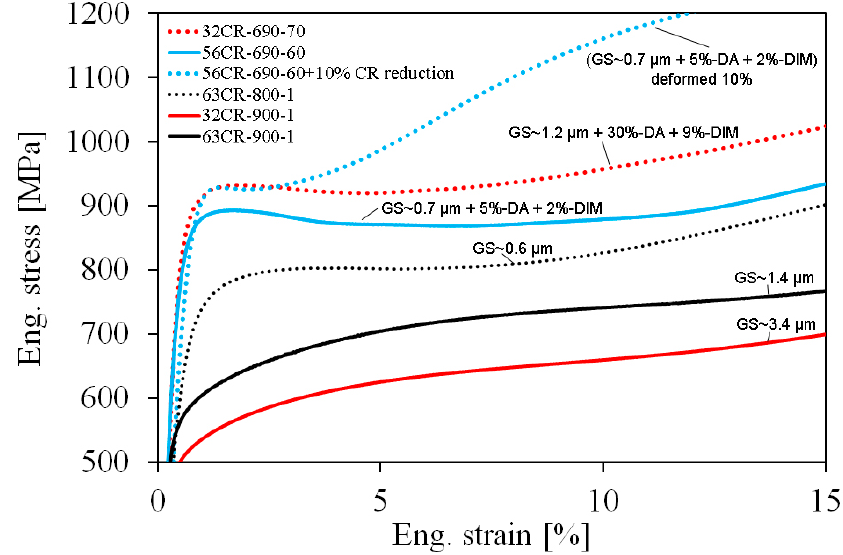
Figure 13. Initial parts of stress–strain curves of various reversed structures of a 30LN steel. Data from References [29,87]. Legend: Reduction (%CR), temperature (°C), duration (s).